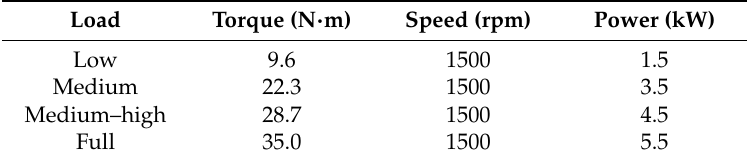
Table 5. Engine loads used.